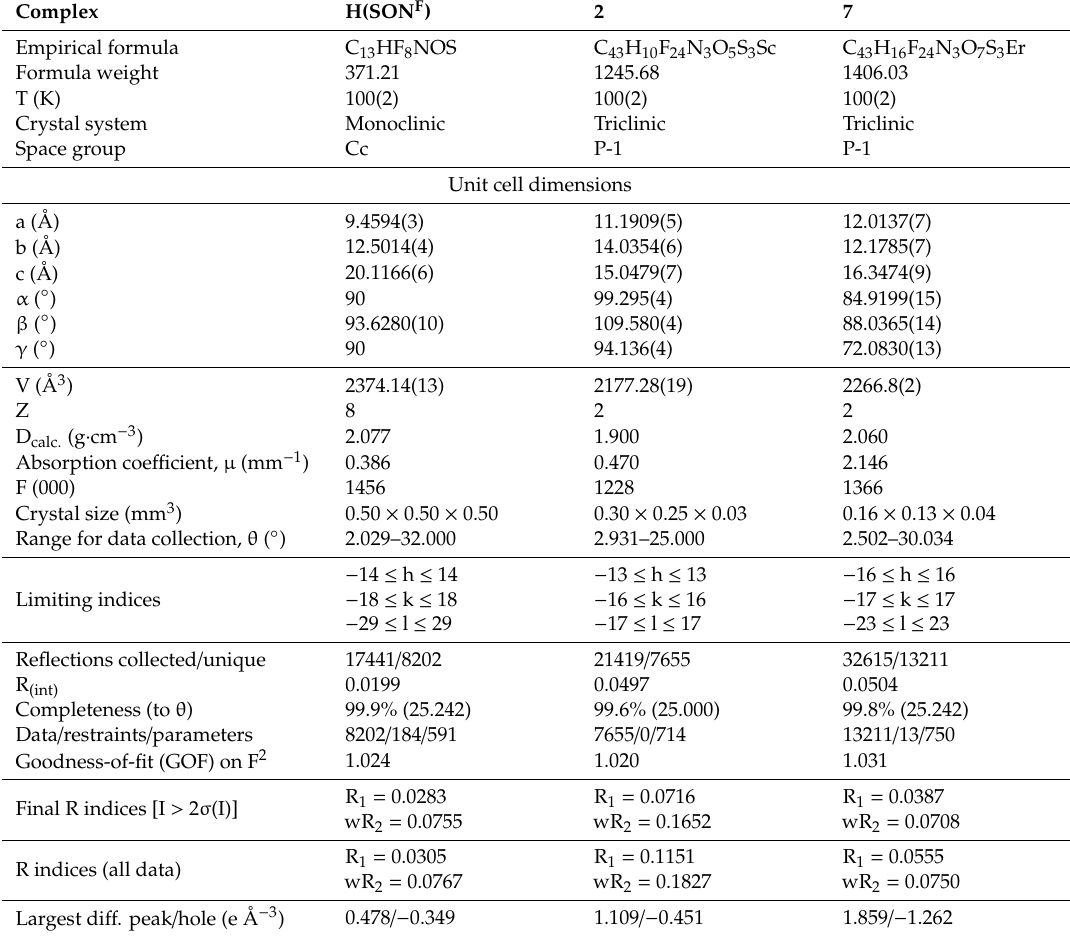
Table 2. X-ray data collection and refinement parameters for H(SON F ), 2 , and 7 . Complex Empirical